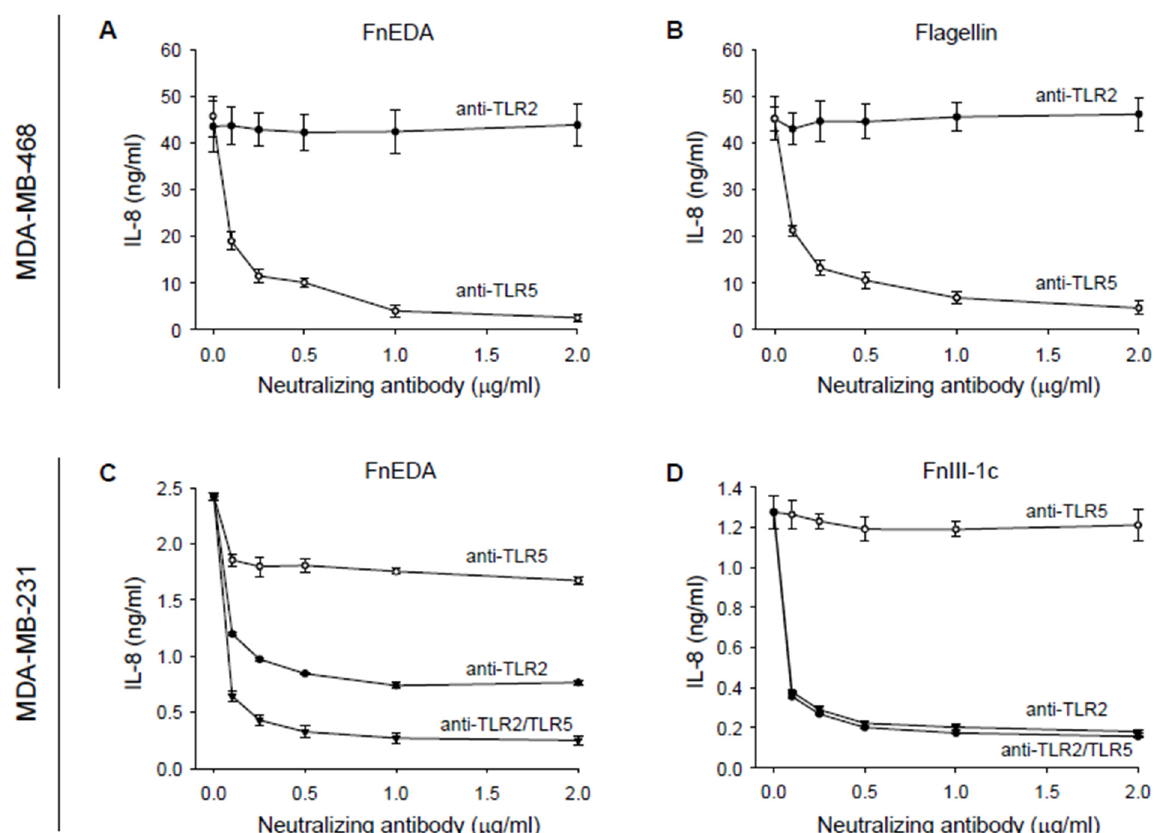
Figure 2. IL-8 synthesis stimulated by FnEDA and FnIII-1c in triple-negative breast cancer cells is TLR-dependent. ( A , B ) MDA-MB-468 and ( C , D ) MDA-MB-231 breast cancer cells were incubated with increasing concentrations of a neutralizing antibody to either TLR2 (anti-TLR2) or TLR5 (anti-TLR5) alone or in combination (anti-TLR2/TLR5) for 1 h prior to treatment with ( A , C ) FnEDA (5 µM), ( B ) the TLR5 agonist, flagellin (50 ng/mL), or ( D ) FnIII-1c (10 µM). After 4 h, conditioned medium was collected and IL-8 concentration determined by ELISA. Data shown represent the mean ± SEM of three experiments performed in triplicate.